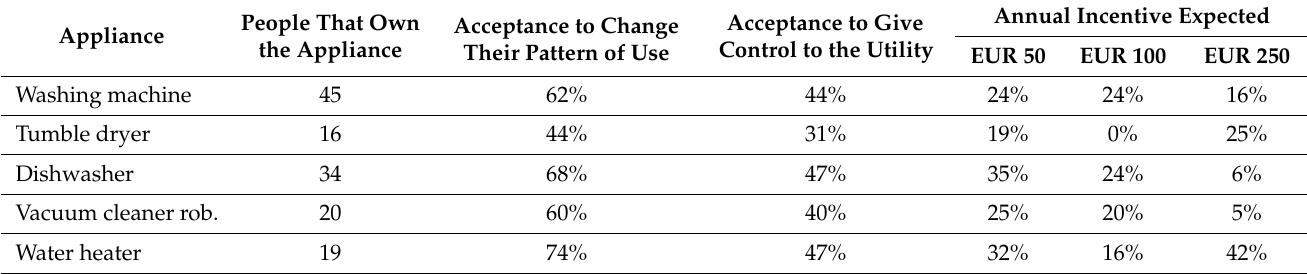
Table A4. Items about the appliances. Note that the percentages refer to the total number of owners of the corresponding